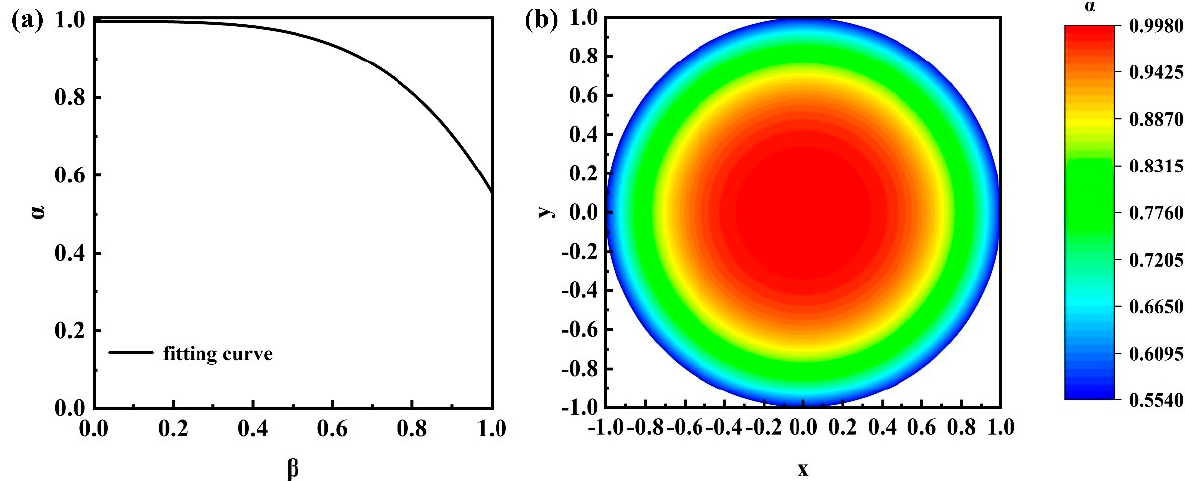
Figure 6. ( a ) The FOV nonuniformity correction coefficient fitting curve; ( b ) the correction coefficient cloud image.